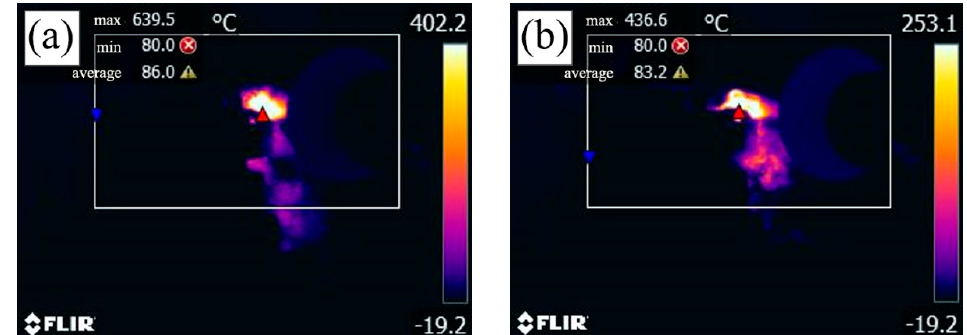
Figure 11. Cutting temperature diagram for the two cutting tools: ( a ) ATS, ( b ) ATSC10.